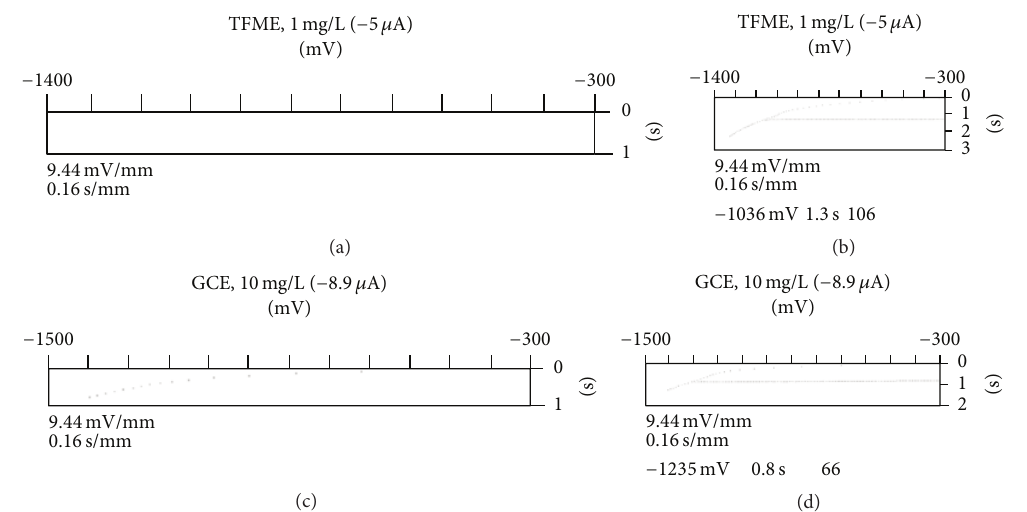
Figure 3: Chronopotentiograms of imidacloprid on a TFME ((a) 𝑐 = 0 mg/L; (b) 𝑐 = 1mg/L, 𝑖 = − 5 𝜇 A) and on GCE ((c) 𝑐 = 0 mg/L; (d) 𝑐 = 10mg/L, 𝑖 = − 8.9 𝜇